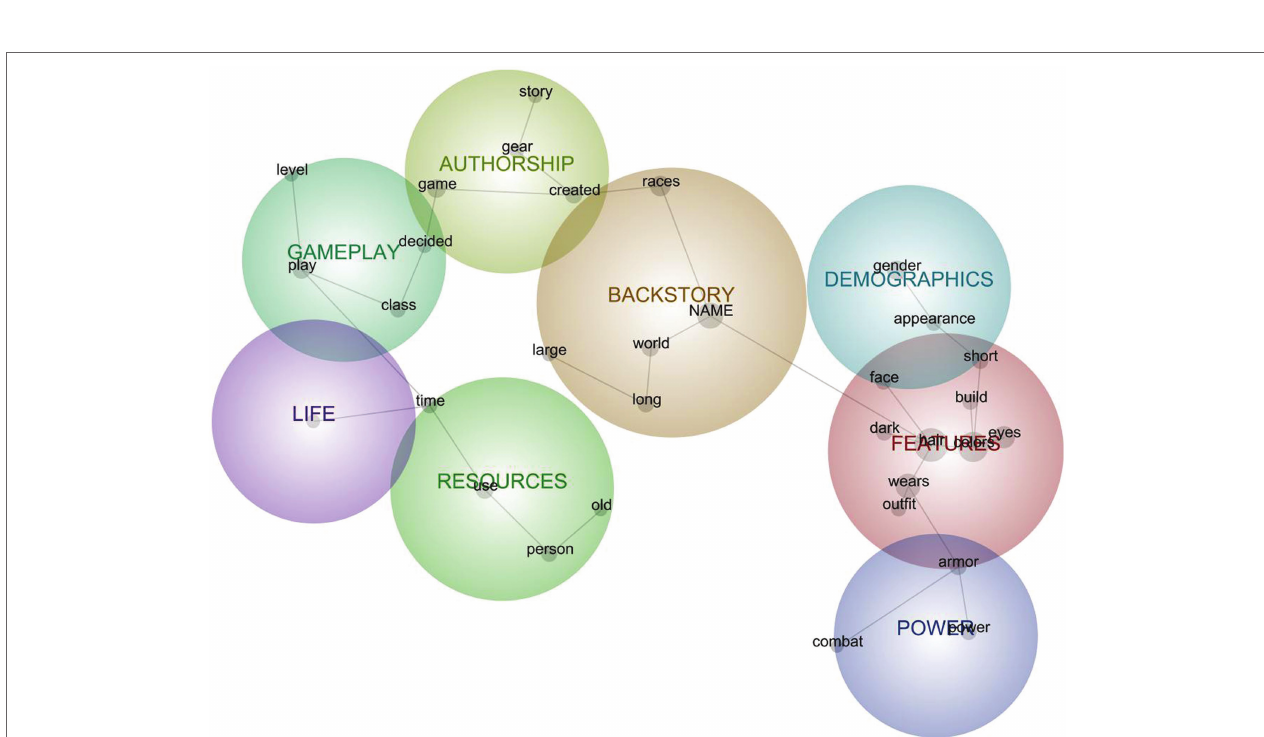
FIGURE 4 | Semantic network model for aggregated descriptions of avatars in Other relations.